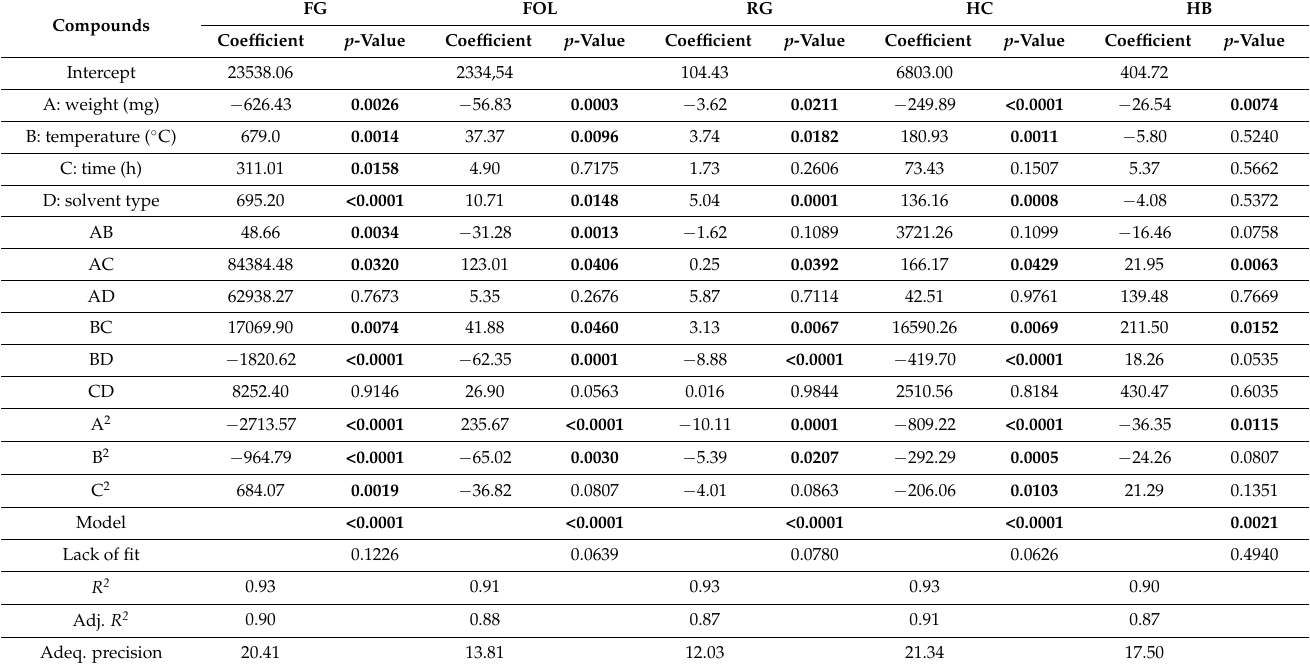
Table 2. Parameters of the analysis of variance (ANOVA) for the fitted